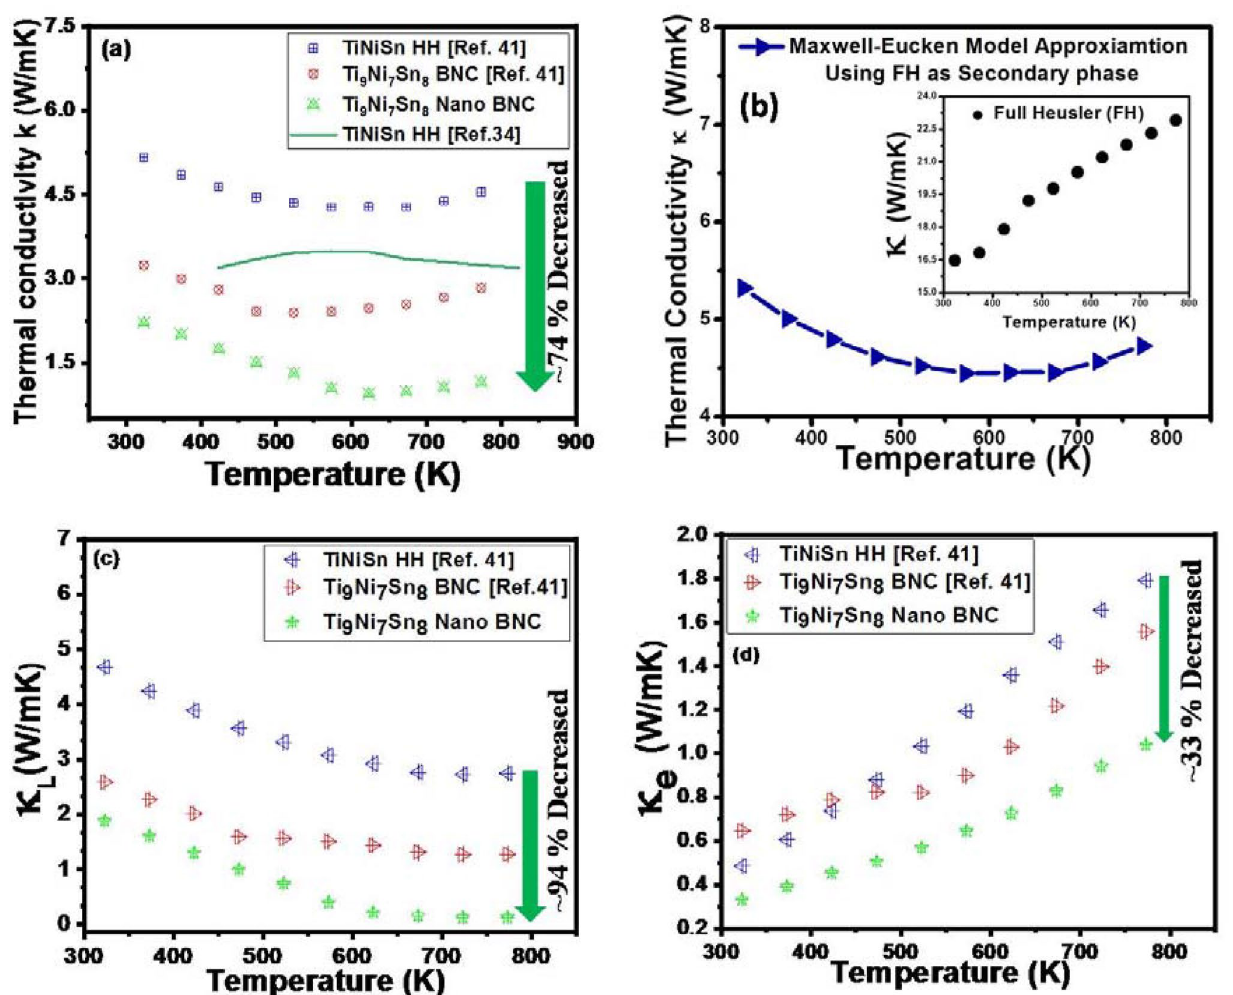
Fig. 4 Temperature dependence behavior of a the total thermal con- ductivity, κ (T) of Ti 9 Ni 7 Sn 8 Nano-BNC and its comparison with that of reported TiNiSn (HH), Ti 9 Ni 7 Sn 8 (BNC) [41]; b calculated effec- tive thermal conductivity for the composites Ti 9 Ni 7 Sn 8 (BNC) using